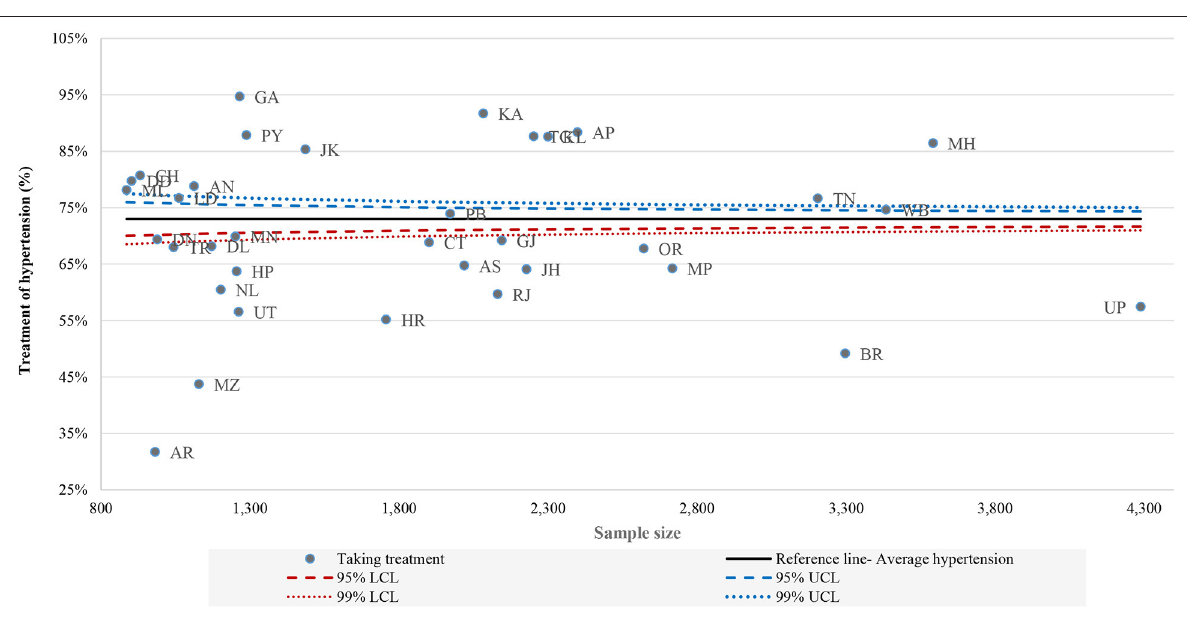
FIGURE 2 | Funnel plot of performance of states: treatment of hypertension, LASI